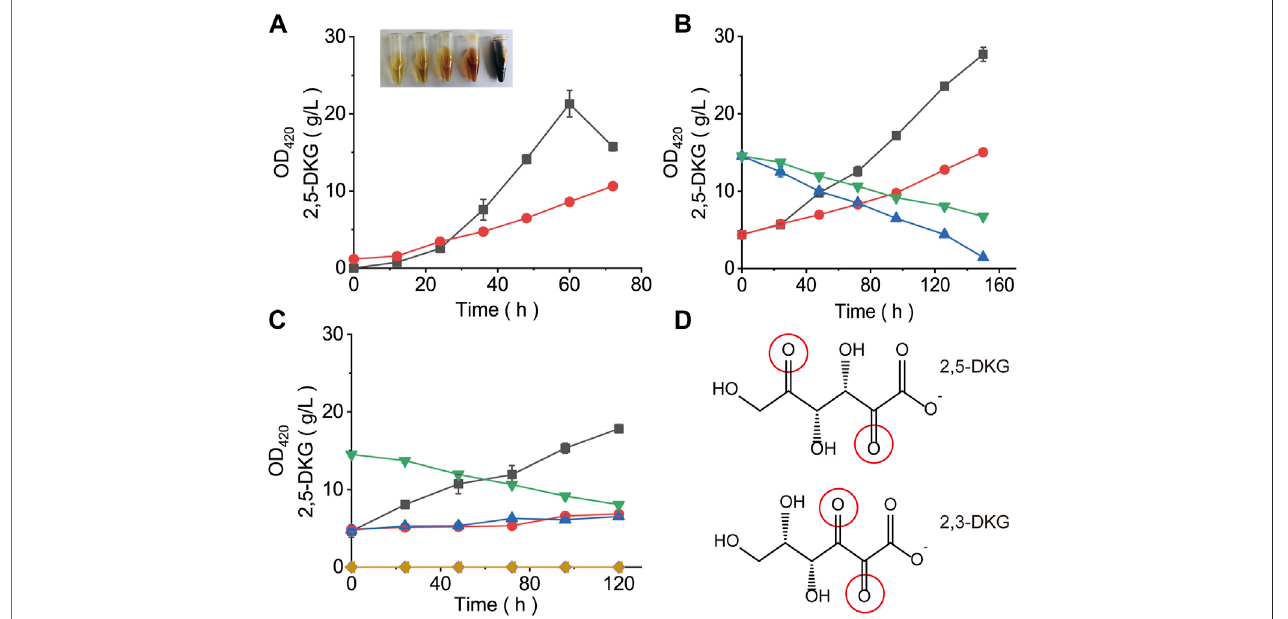
FIGURE 4 | Browning formation (absorbance at 420 nm) and the concentration of 2,5-DKG under different conditions. (A) Concentration of 2,5-DKG and absorbanceat420 nminfermentationbroth.Black=2,5-DKGconcentration.Red=Absorbanceat420 nm.Withincreasedfermentationtime,2,5-DKGlevelsgradually decreased,andthedegreeofbrowninggraduallyincreased. (B) 2,5-DKGconcentrationandabsorbanceat420 nminbrothplusglutamine.Red=OD 420 incontrolcells without glutamine. Black = OD 420 in the experimental group plus glutamine. Green = 2,5-DKG concentration in control cells. Blue = 2,5-DKG concentration in the experiment group. (C) 2,5-DKG concentration and absorbance at 420 nm in broth plus browning inhibitor. Black = OD 420 in control cells without a browning inhibitor. Blue = OD 420 in the experimental group plus the browning inhibitor sodium sul fi te. Red = OD 420 in the experimental group plus the browning inhibitor potassium sul fi te. Green = 2,5-DKG concentration in control cells. Yellow = 2,5-DKG concentration in the experiment group. (D) 2,5-DKG and 2,3-DKG structures.